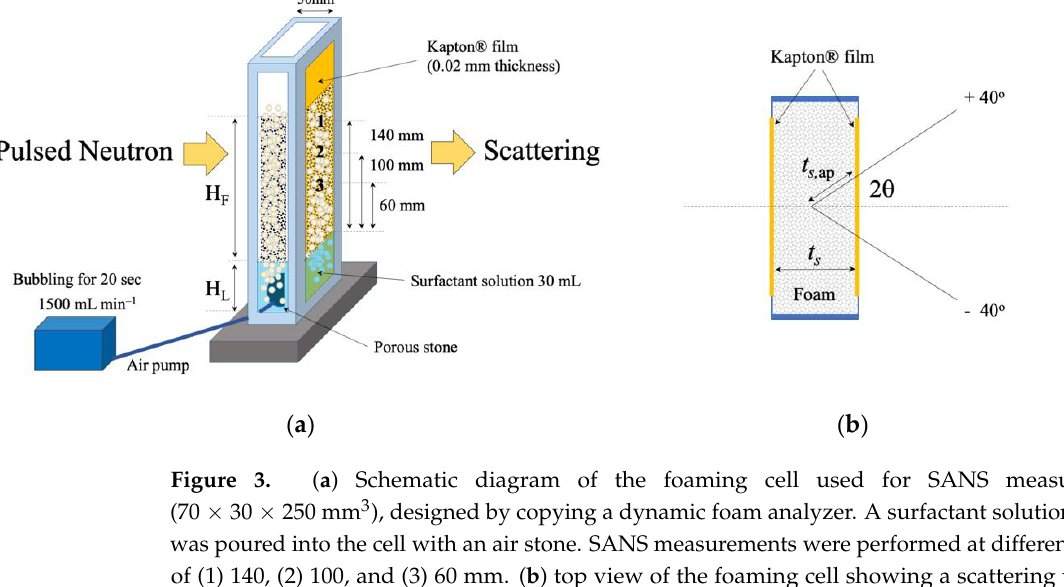
Figure 3. ( a ) Schematic diagram of the foaming cell used for SANS measurements (70 × 30 × 250 mm 3 ), designed by copying a dynamic foam analyzer. A surfactant solution (30 mL) was poured into the cell with an air stone. SANS measurements were performed at different heights of (1) 140, (2) 100, and (3) 60 mm. ( b ) top view of the foaming cell showing a scattering path and scattering 2 (the maximum angle is 40°).